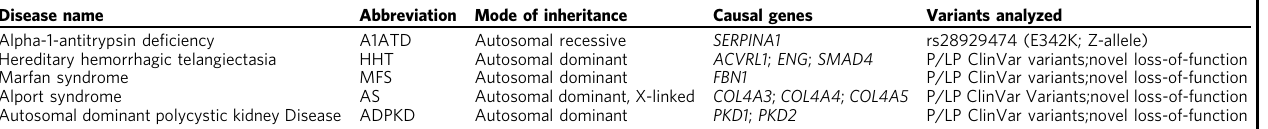
Table 1 Diseases selected for molecular validation and genomic analysis. Disease